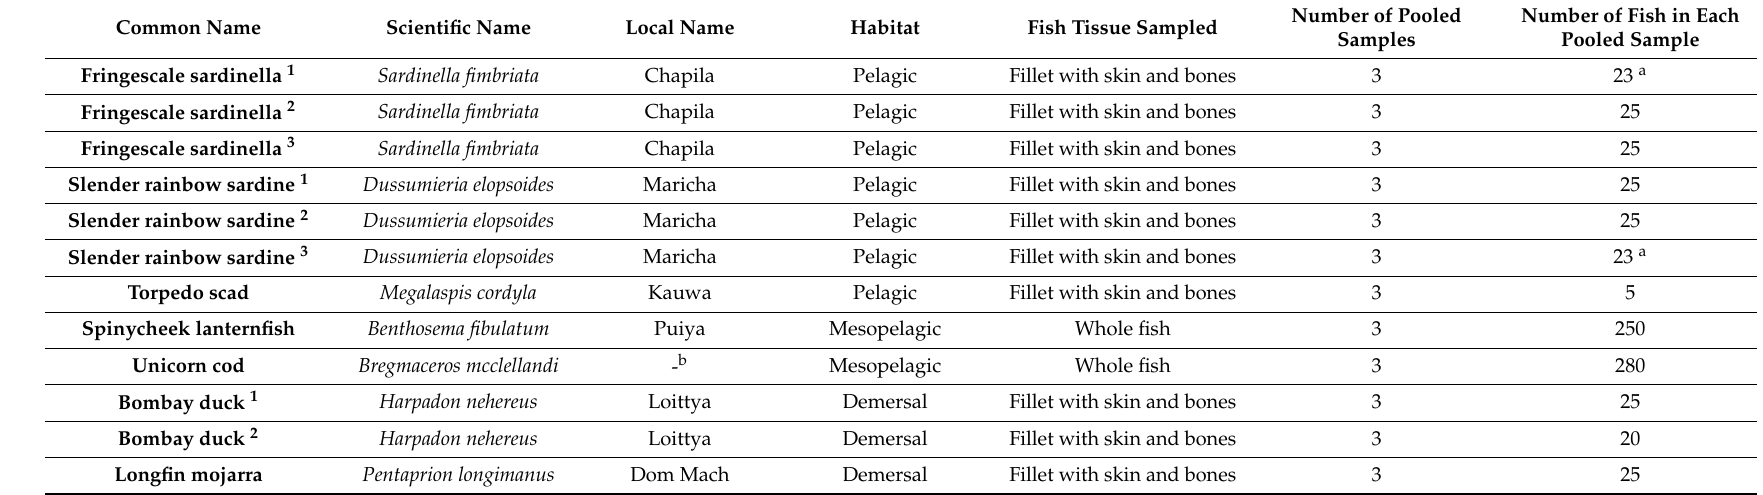
Table 1. Identification details and overview of fish species sampled from